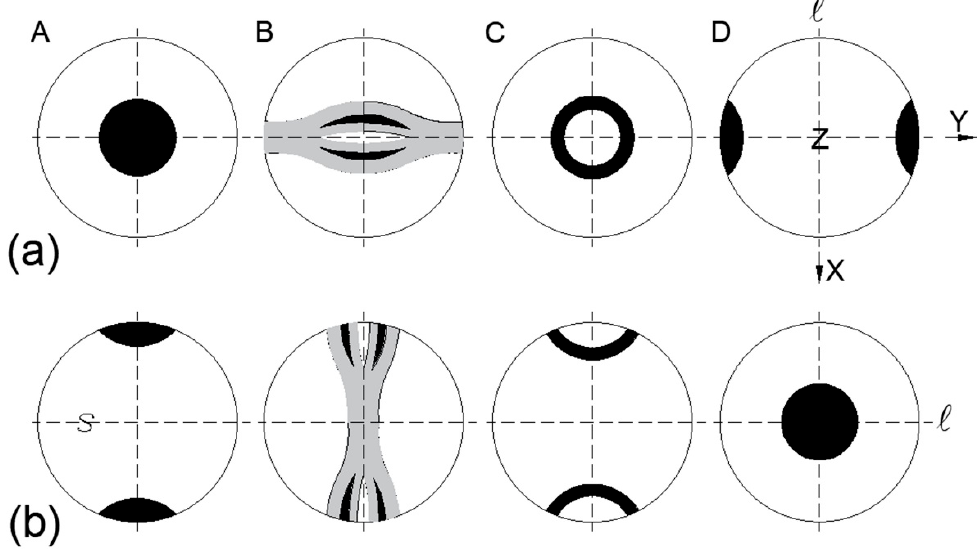
Figure 13. Schematic of quartz c-axis texture types relative to sample coordinates X, Y, and Z. ( a ) Projection on the foliation plane XY used in this paper. X is the lineation l . A: c axes perpendicular to foliation; B: crossed girdle; C: c-axis small circle girdle; and D: c-axis maximum at Y. ( b ) More conventional projection on the plane XZ defined by the normal to the foliation s and the lineation l .